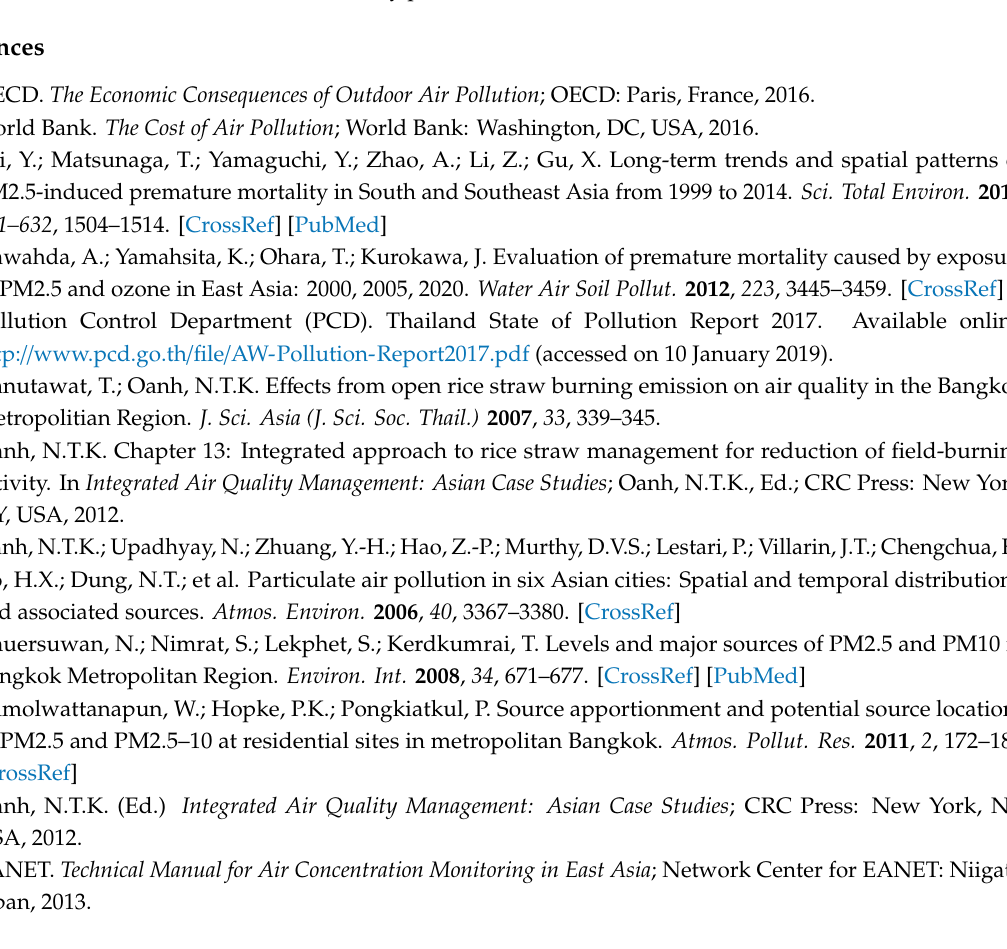
Figure A3. ( a ) 22–29 February 2016, 49.7 µ g / m 3 ; ( b ) 11–18 January 2016, 13.2 µ g / m 3 . Examples of HYSPLIT backward trajectories arriving at PCD site on the weeks with ( a ) the highest concentration; and ( b ) the lowest concentration, in the dry period. Source: Tanatat, 2018 (see text).